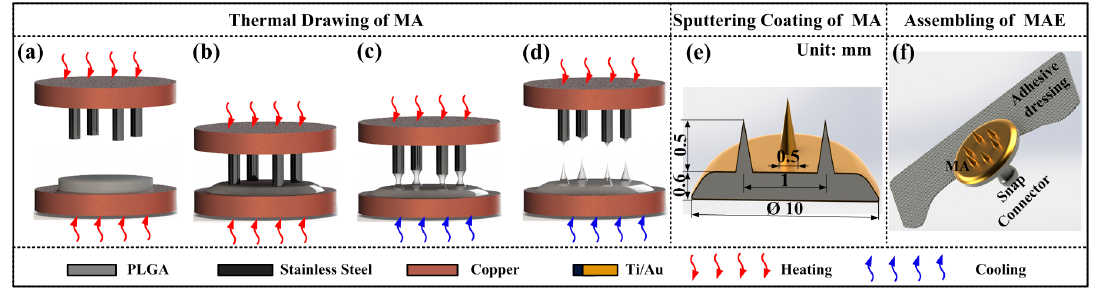
Figure 2. Fabrication process of MAE. ( a )–( d ): thermal drawing process of MA, ( e ) Sputtering coating Ti/Au film on the MA, and ( f ) the assembly of MAE.